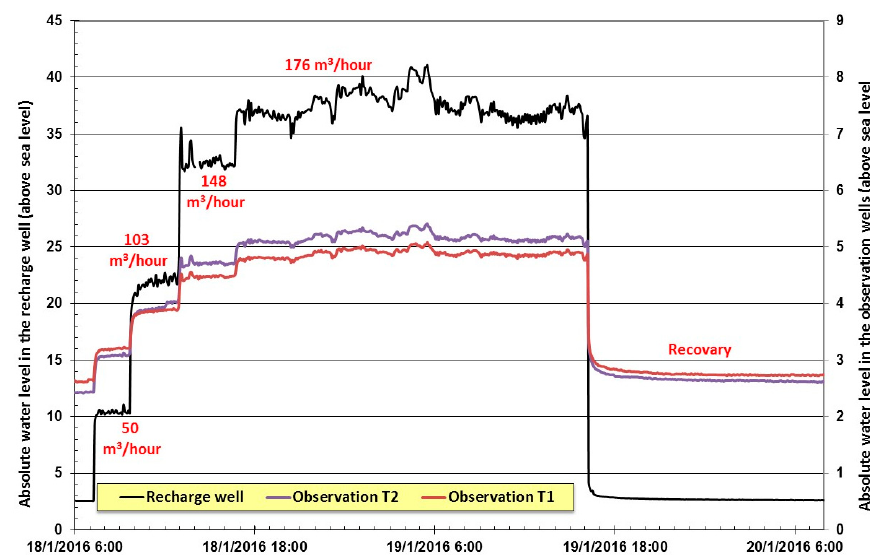
Figure 8. The behavior of the water level in the recharge well and the observation wells during the recharge test (the numbers in red are the hourly discharge at each step).